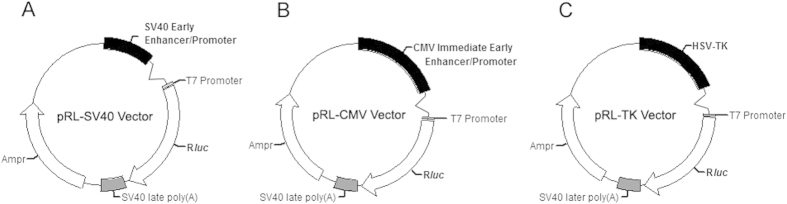
Control vectors.Abbreviations: Ampr, ampicillin resistance gene; Rluc, renilla luciferase gene; SV40 early enhancer/promoter, simian vacuolating virus 40 early enhancer/promoter; CMV Promoter, human cytomegalovirus immediate-early promoter; HSV-TK, herpes simplex virus thymidine kinase promoter.